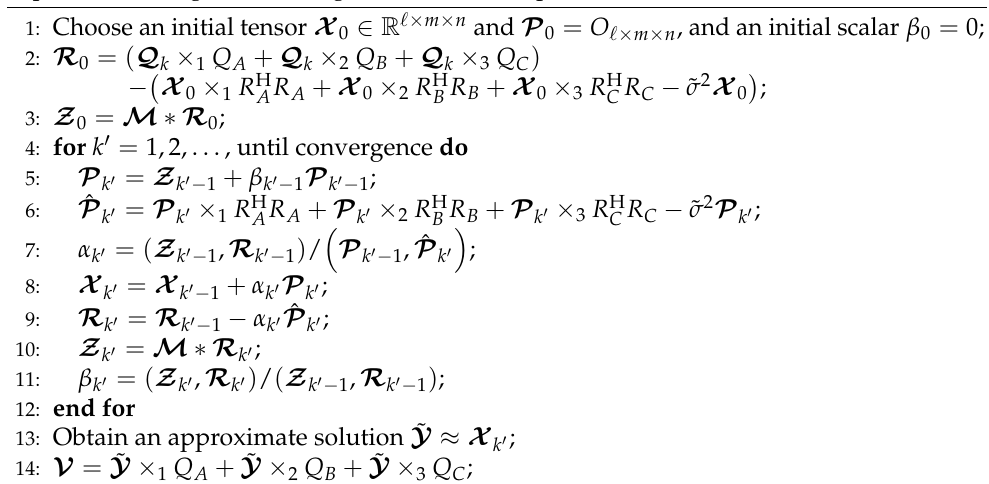
Algorithm 4: PCG method over tensor space for the 5-th line of Algorithm 1 [Pro- posed inner algorithm using the Schur